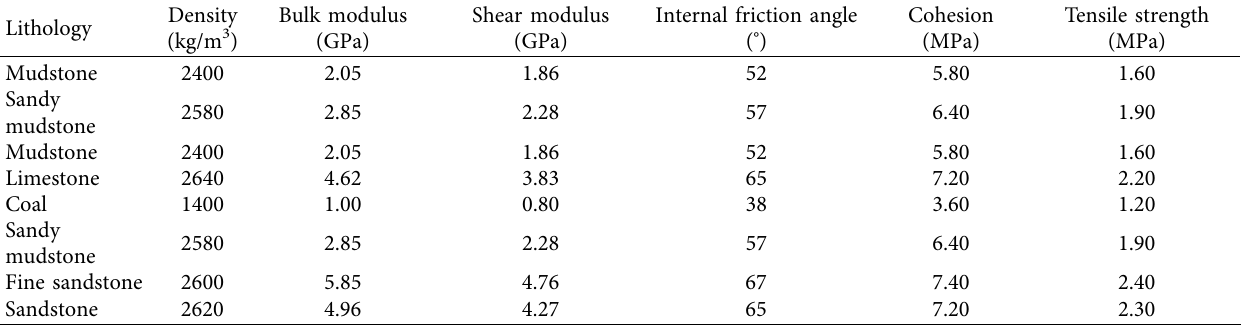
Table 1: Parameters of model material.